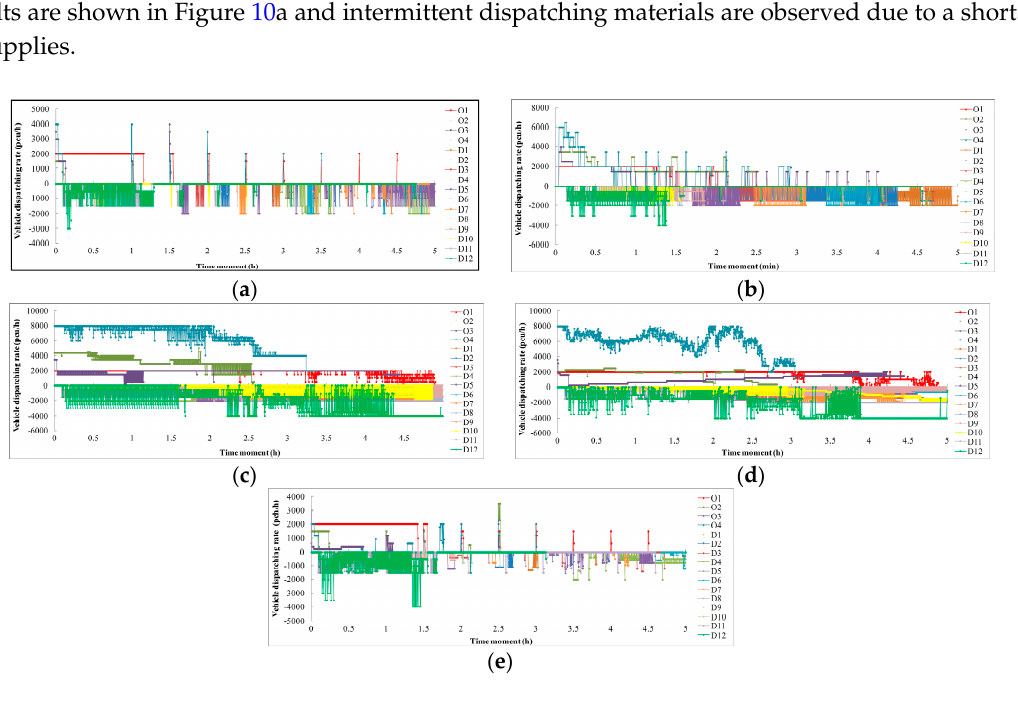
Figure 10. The multi-objective emergency material dispatching results in the dynamic situation: ( a ) dynamic limit emergency material supply; ( b ) dynamic emergency material demand; ( c ) dynamic travel time; ( d ) dynamic road capacity; ( e ) multiple dynamic